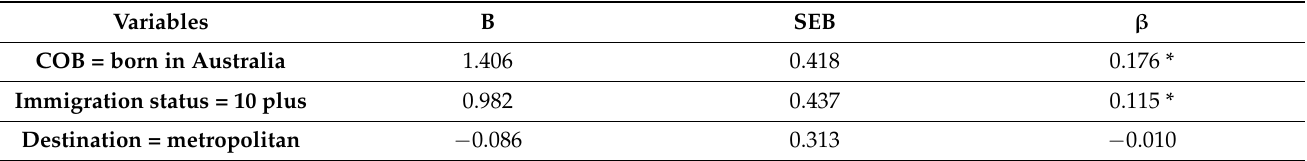
Table 6. Regression analysis summary of the host’s variables predicting the number of repeat visits of travel